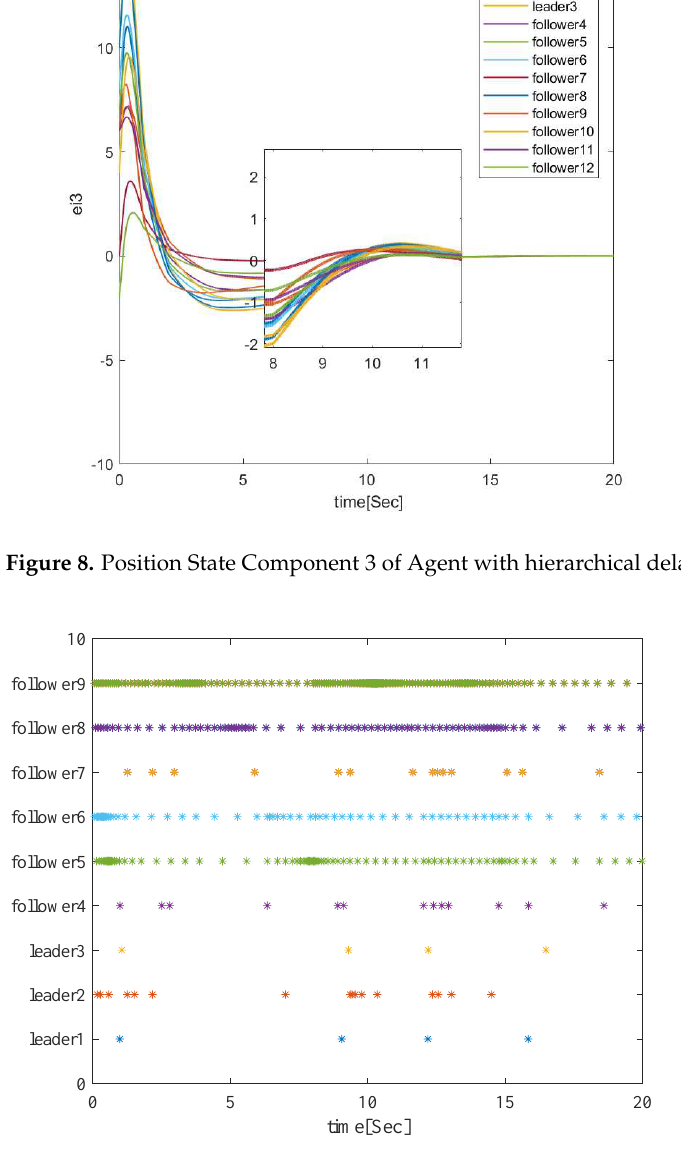
Figure 9. Event-trigger numbers under the event-based control law of Equation (5) with layer-to-layer